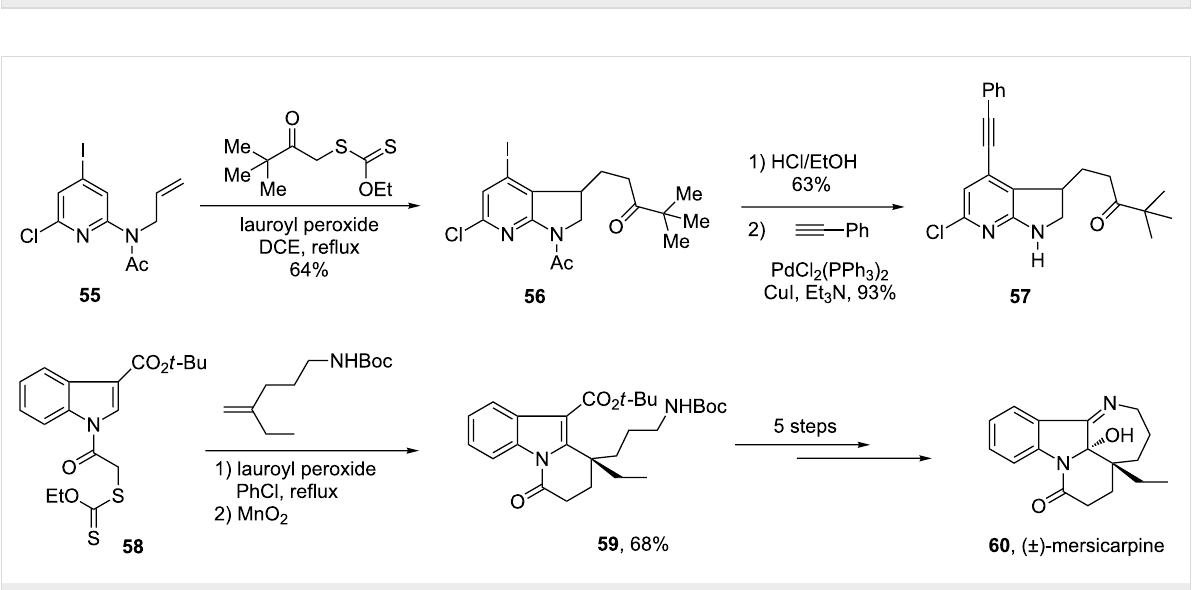
Scheme 11: Synthesis of functionalised azaindoline and indole